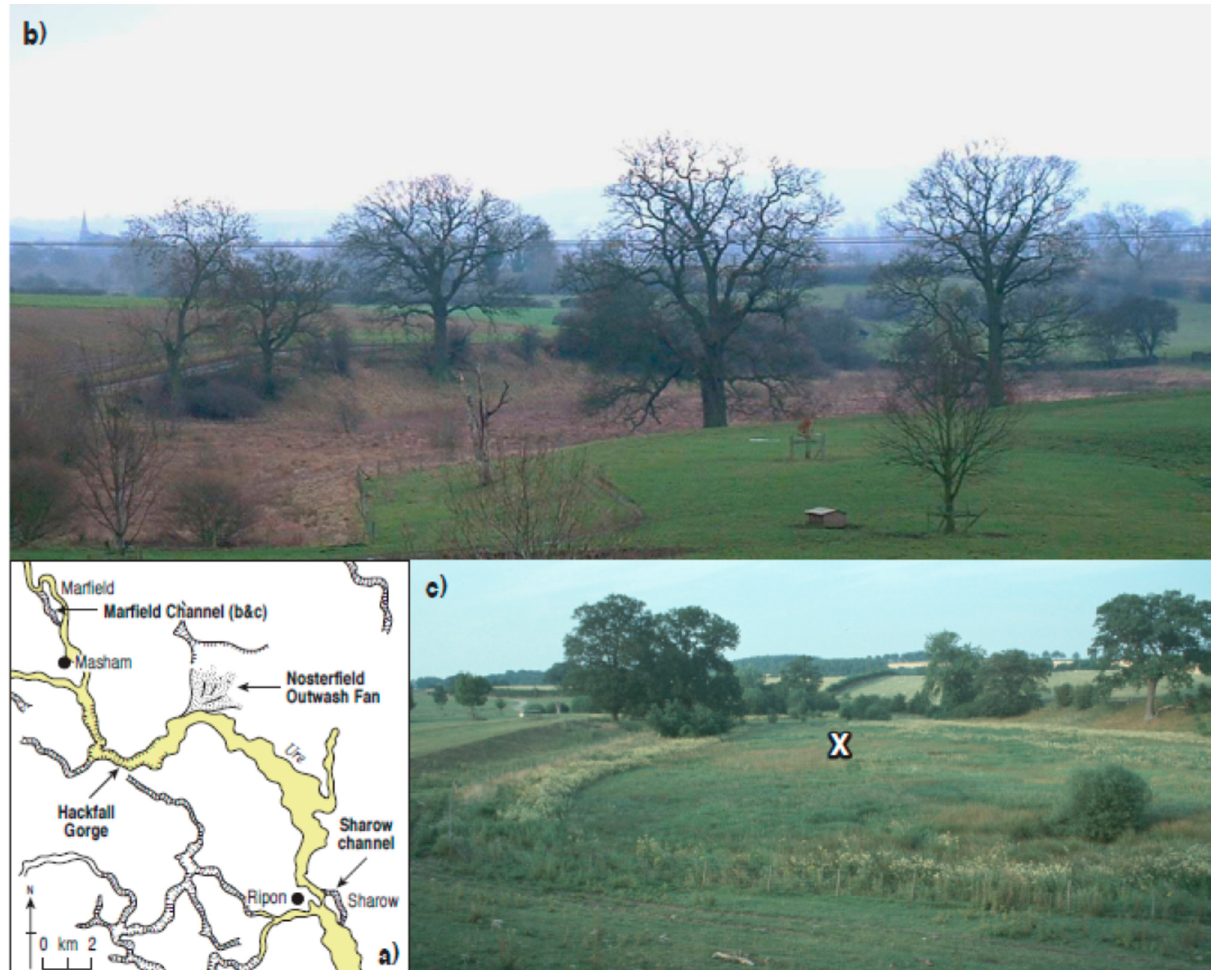
Figure 3. ( a ) Location of geomorphological channel features mentioned in the text. Yellow shading indicates alluvial sediments in the current Ure valley. ( b ) The High Mains abandoned channel of the Ure at Marfield. ( c ) View towards the location of the coring site at Marfield, which is marked with an X, looking north. Photographs by Wishart Mitchell. For detailed location of the channel relative to the River Ure and the Marfield Quarry, see Figure 1.